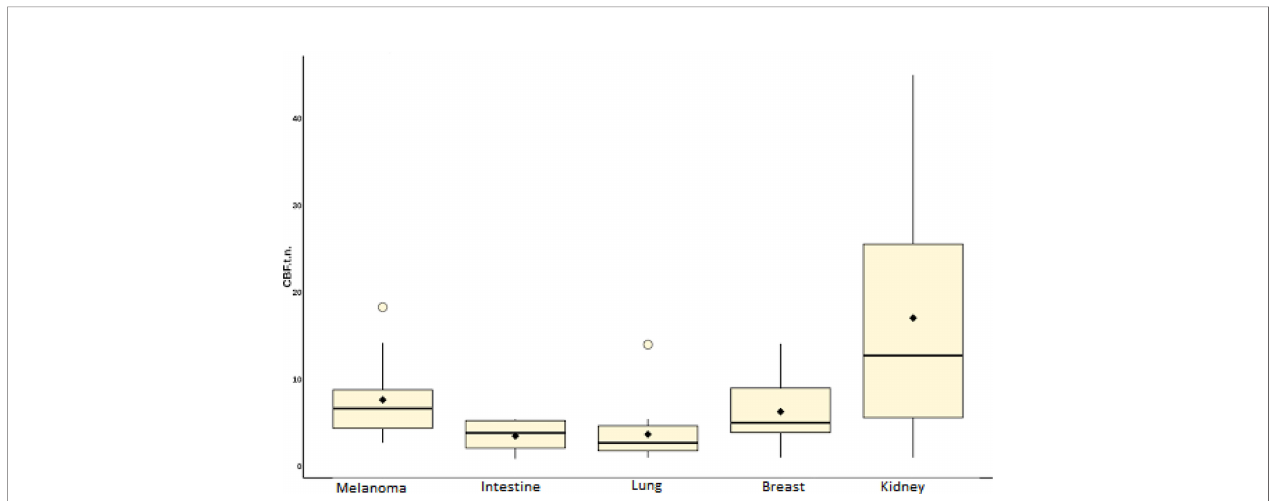
FIGURE 9 | Box plot showing the value of intratumoral blood fl ow in the group of metastatic brain lesions.